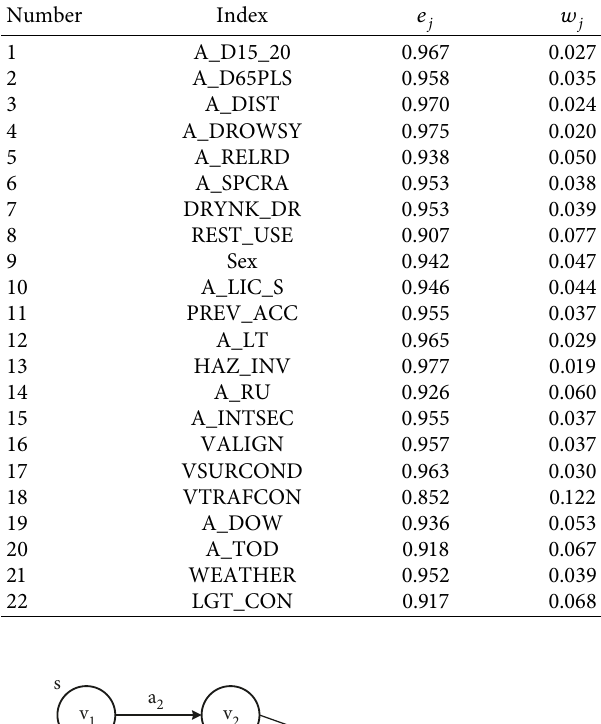
Table 3: Weights of accident cost impact factors.